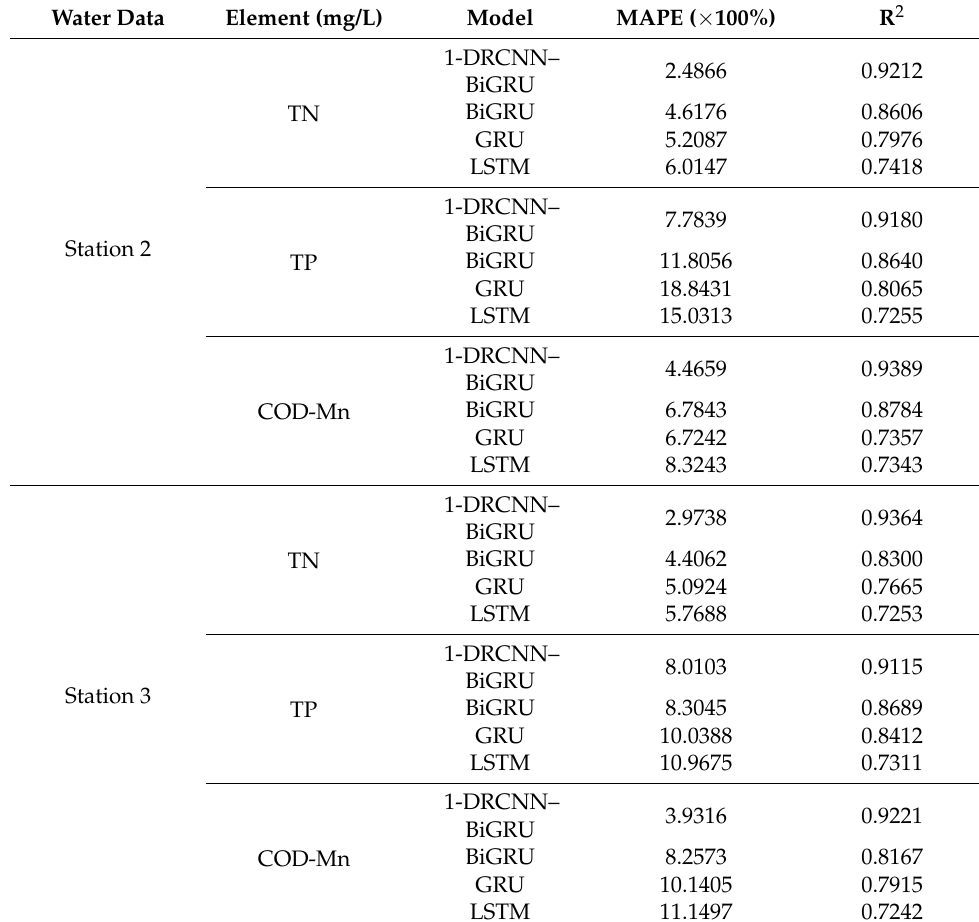
Table 4. Evaluation metrics of different models on stations 1 and